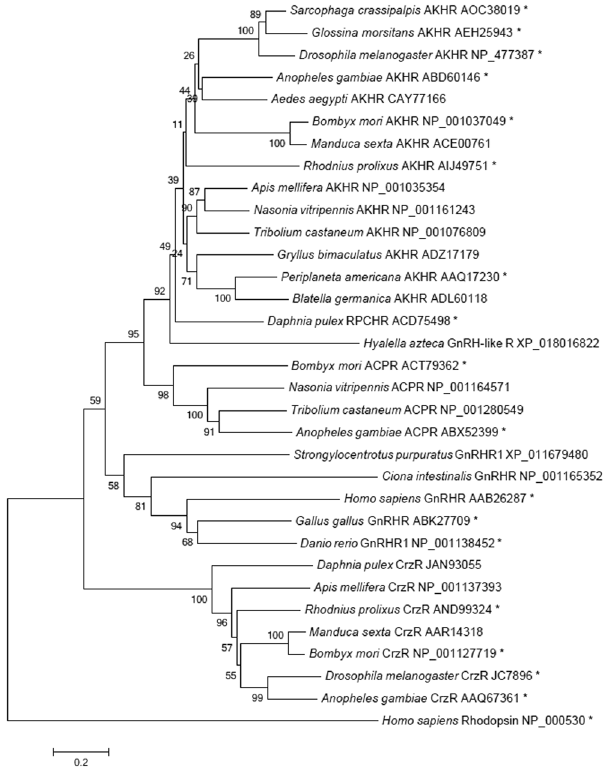
Figure 3. A neighbour-joining tree of GnRH receptor subfamily (i.e. GnRH/AKH/RPCH/ACP/Crz-type receptors). Phylogenetic and molecular evolutionary analyses were conducted by using MEGA vers. 6. Alignments were conducted with MUSCLE. Bootstrap-support values (1–100) are based on 1000 replicates using the Jones Taylor Thornton model and are indicated on the nodes. The human rhodopsin receptor was used as an outgroup to root the tree. Proteins marked with an asterisk were pharmacologically characterised. The scale bar allows conversion of branch length in the dendrogram to genetic distance between clades (0.2 = 20% genetic distance). Abbreviations used: AKHR, AKH receptor; RPCHR, RPCH receptor; ACPR, ACP receptor; CrzR, corazonin receptor; GnRHR, GnRH receptor.